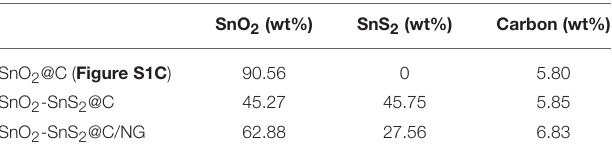
TABLE 1 | Contents of each component in the